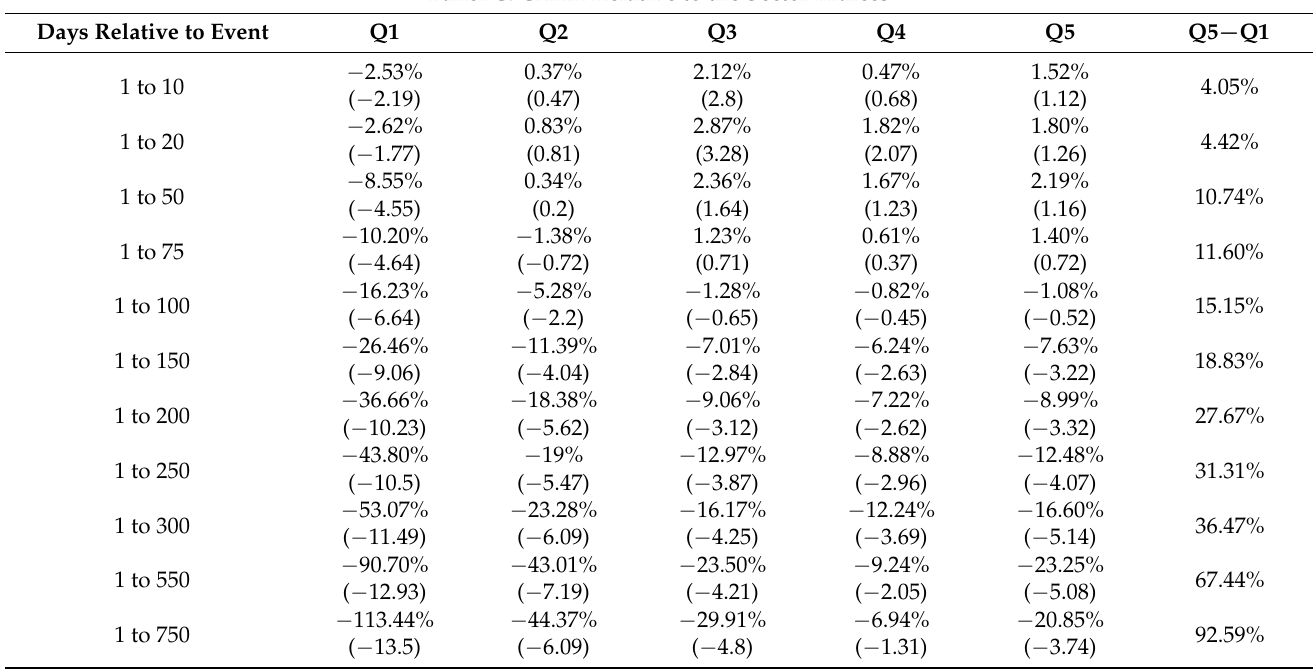
Table 2. Cont. Panel C: CAAR Relative to the Sector